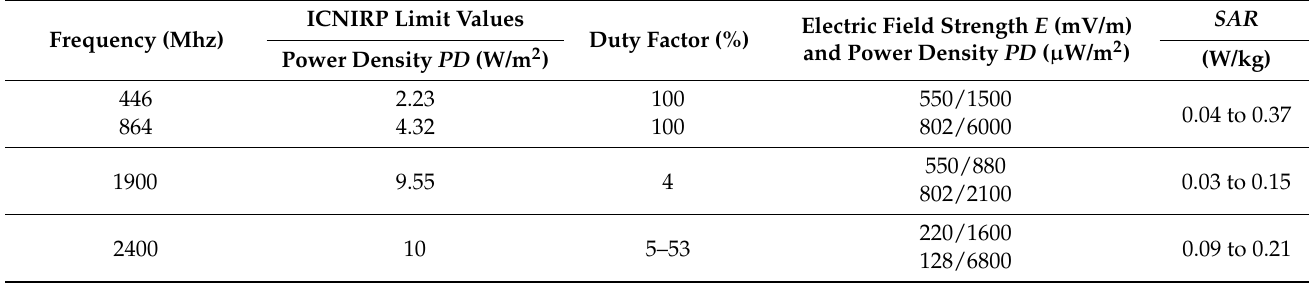
Table 6. Characteristic values of baby-surveillance devices: frequency, duty factor (%), electric field strength E (V/m) measured at a distance of 50 cm, SAR (W/kg) measured close to the baby unit, and ICNIRP limit values ( [39]). Frequency